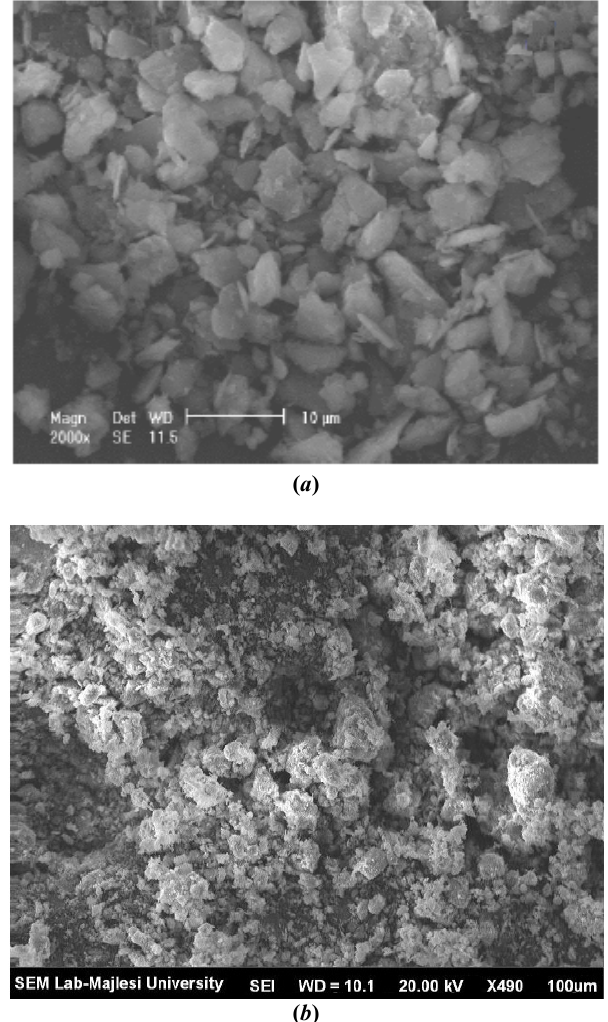
Fig. 5 . (a) Scanning electron micrograph of natural clinoptilolite (b) Scanning electron micrograph of clinoptilolite with immobilized